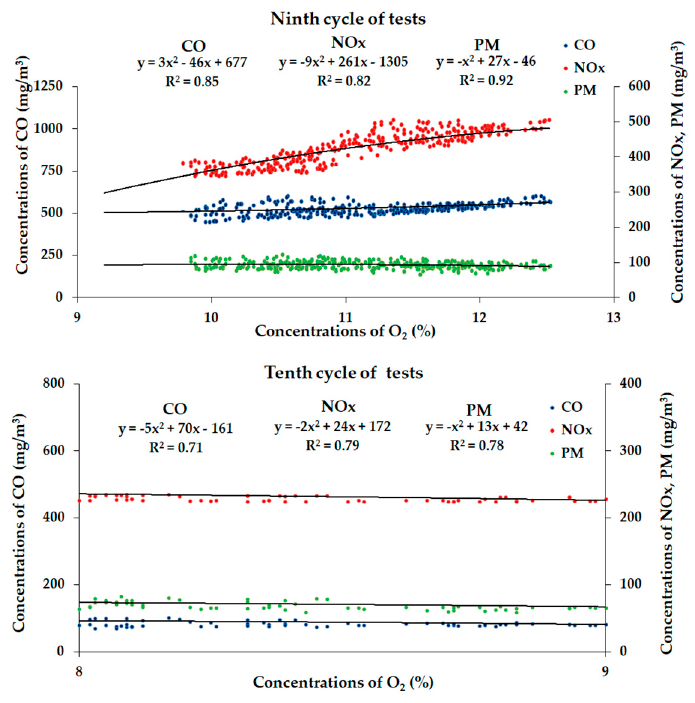
Figure 10. Mass distribution of harmful substances to the remaining amount of oxygen for the ninth and tenth cycle of tests.